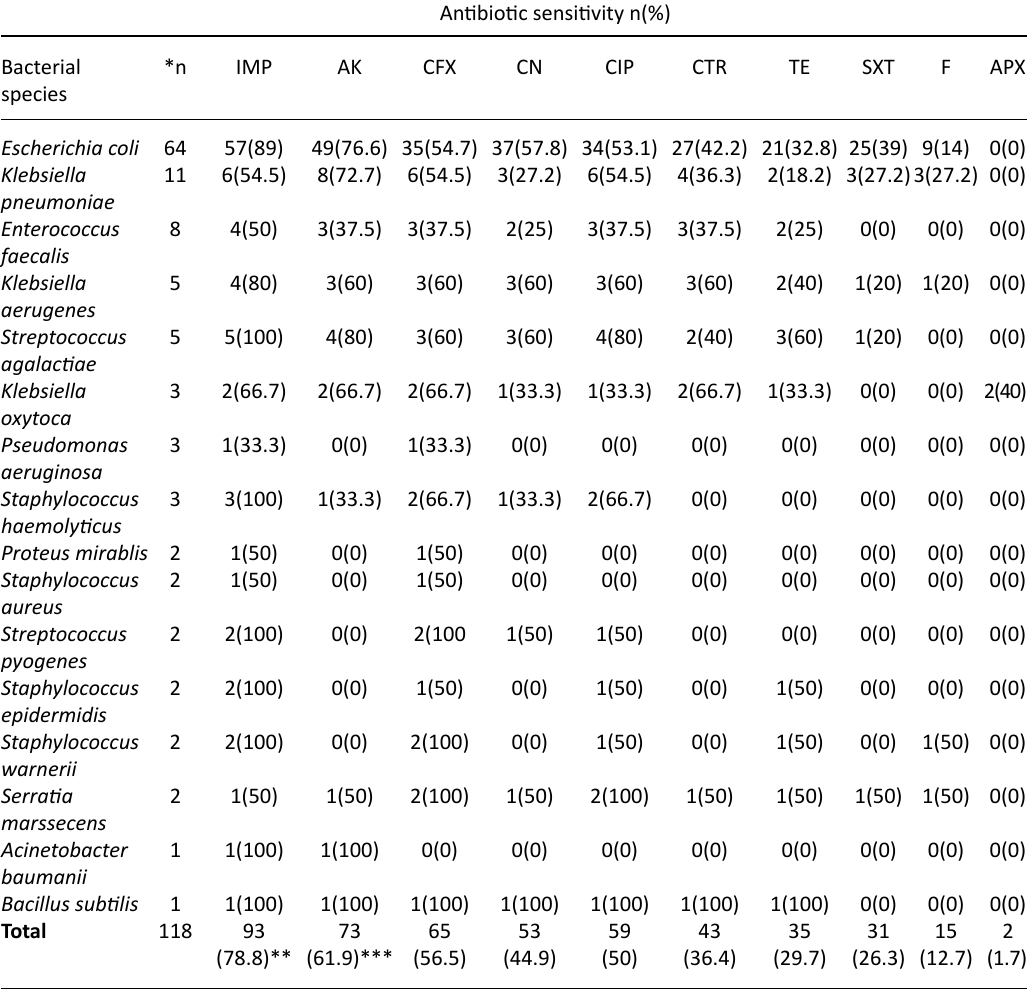
Table 4. Antibiotic sensitivity profile of bacterial species isolated from adult diabetic patients with UTI Antibiotic sensitivity